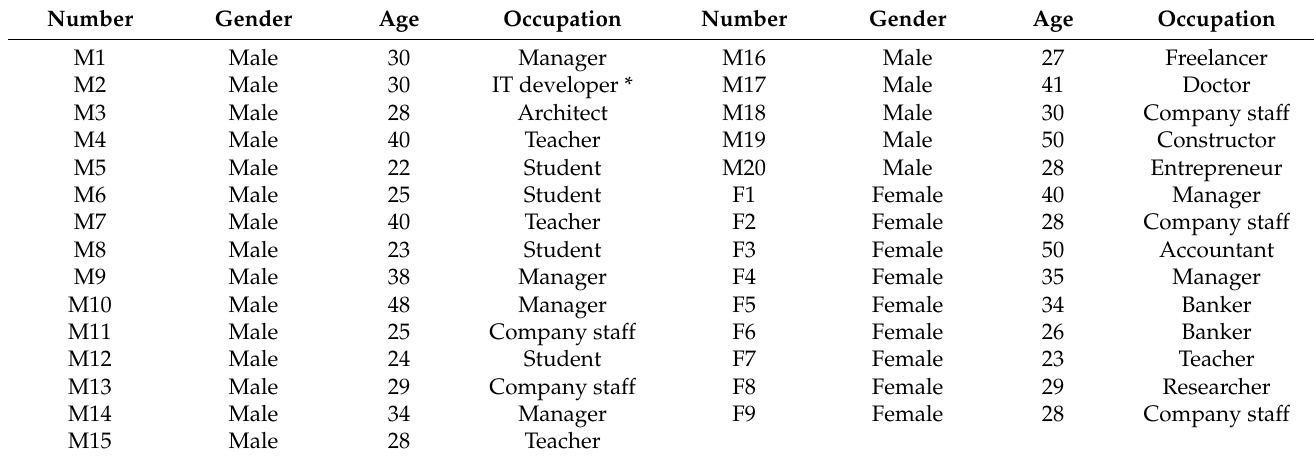
Table 1. Demographic information of